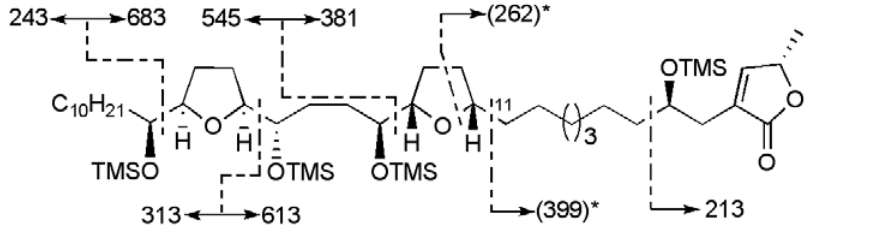
Figure 3. EIMS fragmentation for derivatised and un-derivatised cis -sylvaticin ( 3 ) [13].